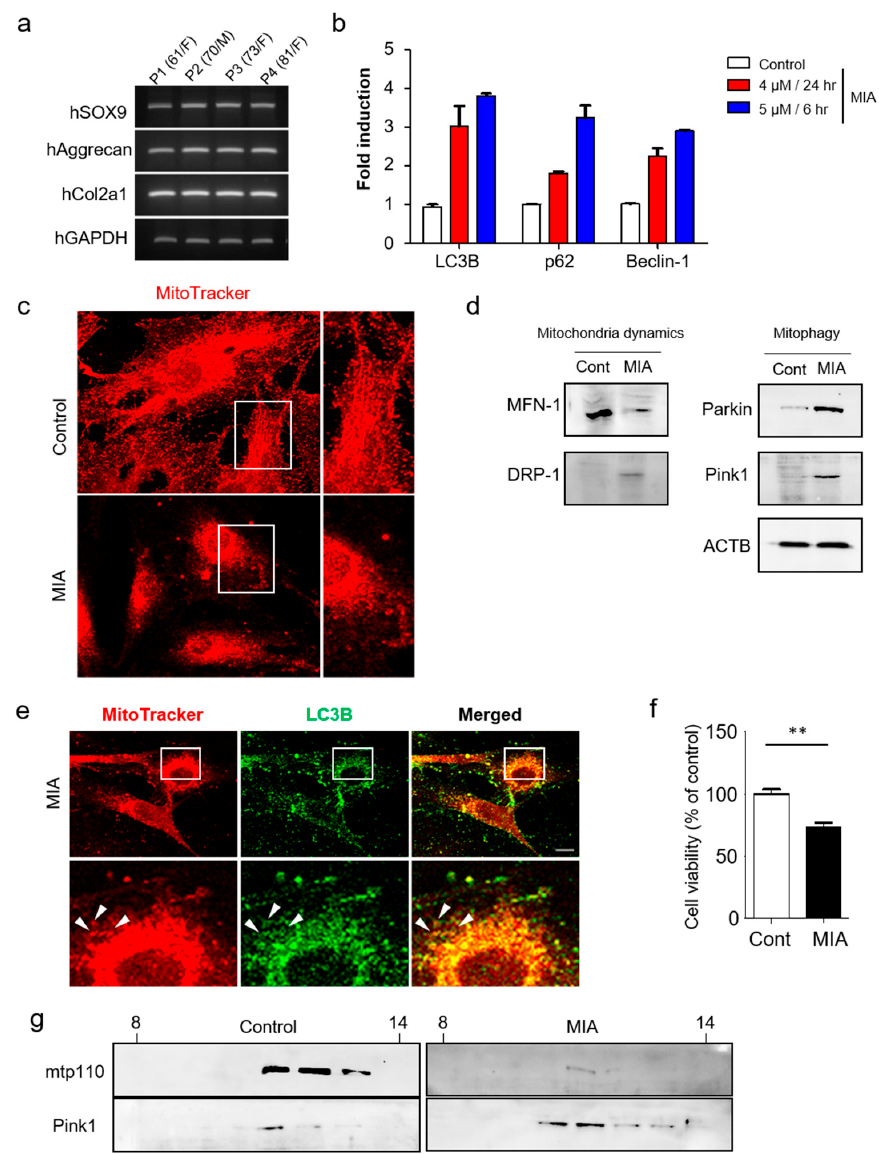
Figure 3. MIA-induced activation of mitophagy in human primary chondrocytes. ( a ) Expression of chondrocyte marker genes ( SOX9 , Aggrecan , Col2a1 ) were measured by RT-PCR in human primary chondrocytes. ( b ) Expression of autophagy related genes were detected by qRT-PCR analysis. ( c ) Mitotracker-red and DAPI staining in MIA-treated (5 µM for 6 h) and control chondrocytes. A higher magnification confocal microscopic image from the selected area is also shown. ( d ) Western blot analysis of mitophagy and mitochondrial dynamic proteins in MIA-treated and control chondrocytes. ( e ) Confocal microscopy images displaying subcellular localization of LC3B (green) and mitotracker (red). White arrows indicate encapsulated mitochondria by LC3B. ( f ) Chondrocytes were examined for MIA-induced cytotoxicity (5 µM treatment for 6 h). ( g ) Western blots were used to detect Pink1 and mtp110 levels in sucrose gradient fractions (30%–60%). Scale bars = 50 µm. 3.3. Pink1 Knock-Out Decreases Cartilage Damage in MIA-Induced Osteoarthritis Using a MIA-induced animal model of OA, we previously showed that overexpression of Pink1 is central to its role in mitophagy. Here, we sought to determine whether suppression of Pink1 expression would be sufficient to prevent cartilage degeneration in MIA-induced OA rats. We first